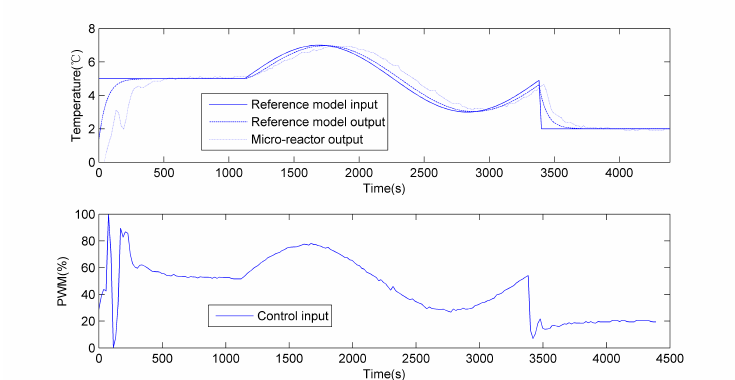
Figure 15. Experimental results with difference reference